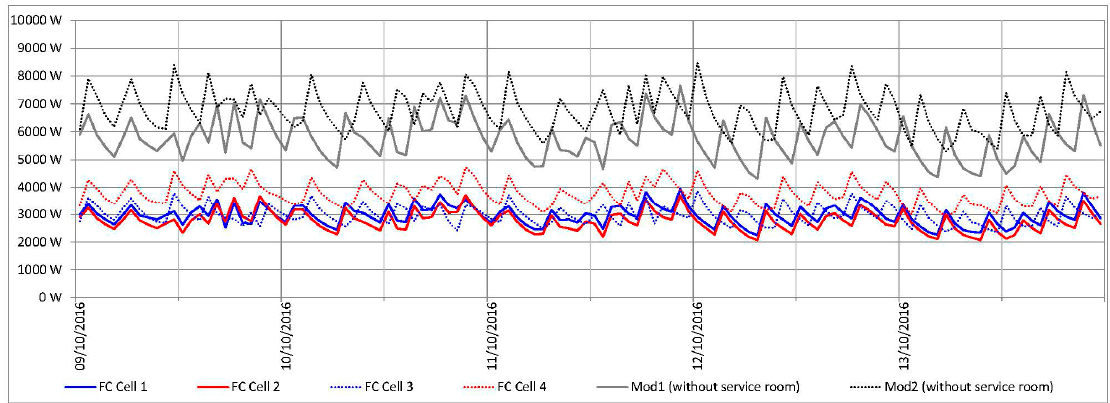
Figure 8. Instant cooling load (W) in cells and modules.